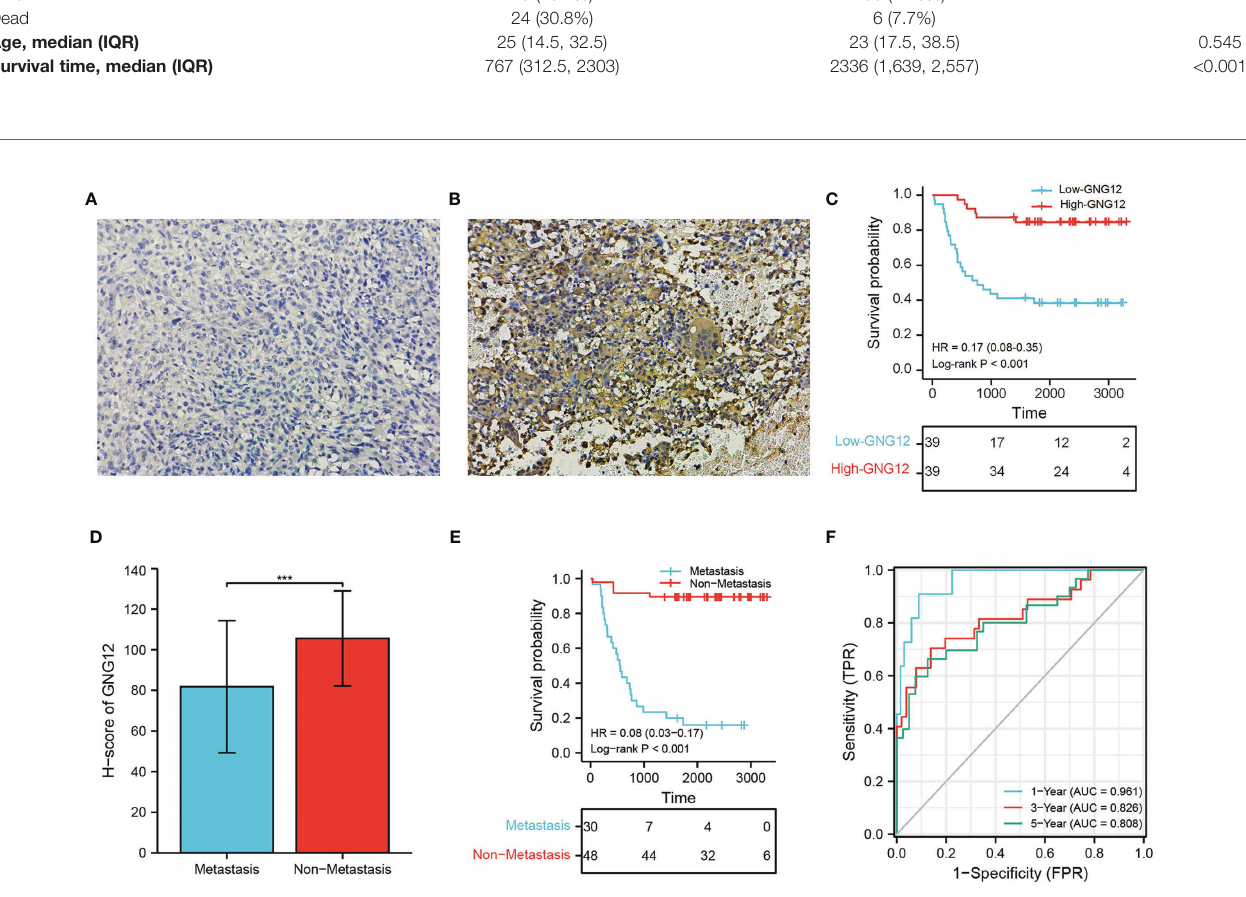
FIGURE 9 | Validation the GNG12 expression and prognostic value of GNG12. (A, B) Low/high H-score of GNG12 ICH images. (C) The effect of low GNG12 expression on the prognosis of osteosarcoma overall survival (OS) is statistically signi fi cant in the validation cohort. (D) In the validation cohort, the H-score level of GNG12 between metastasis and non-metastasis groups. (E) The effect of metastasis on the prognosis of osteosarcoma overall survival (OS) is statistically signi fi cant in the validation cohort. (F) Time-dependent ROC curves: 1 year (AUC = 0.961), 3 years (AUC = 0.826), and 5 years (AUC = 0.808). ***p <